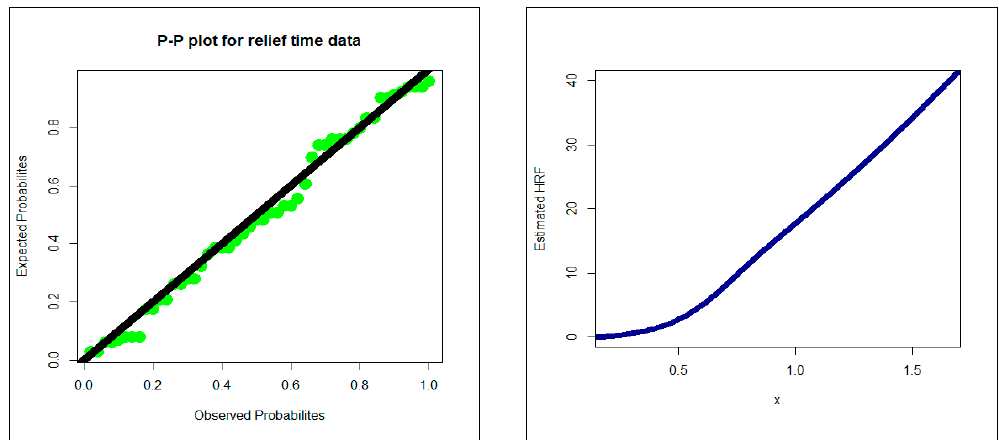
Figure 9. P-P panel (left) and estimated HRF (right) for the relief times.